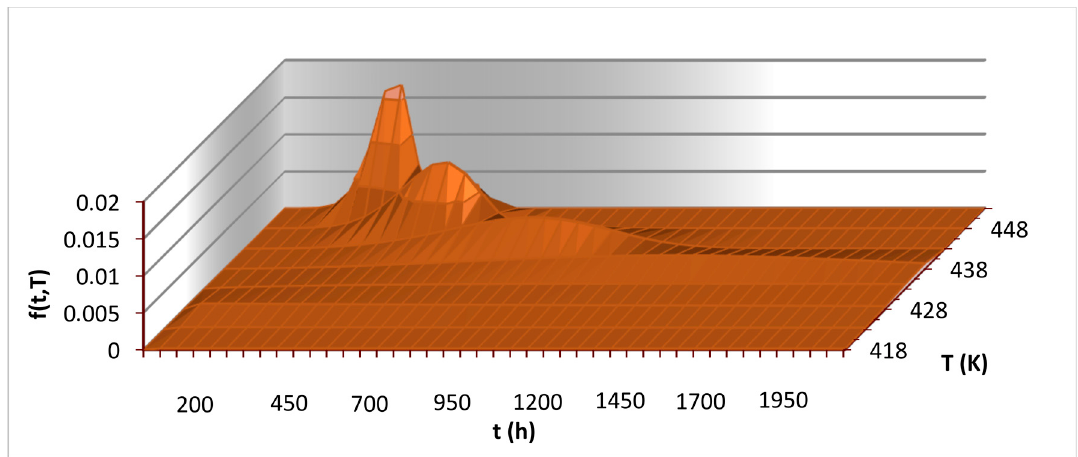
Figure 11. 3D plot of estimations of the density of probability of the Weibull distribution depending on temperature for the proposed probabilistic model.